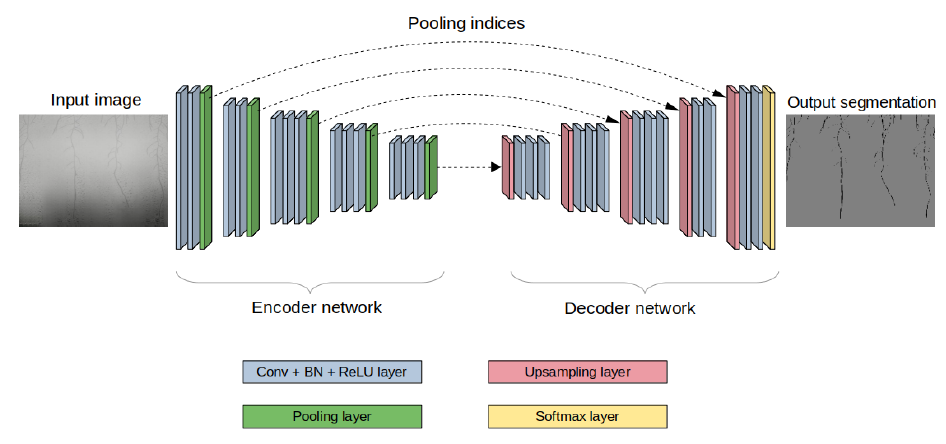
Figure 5. SegNet